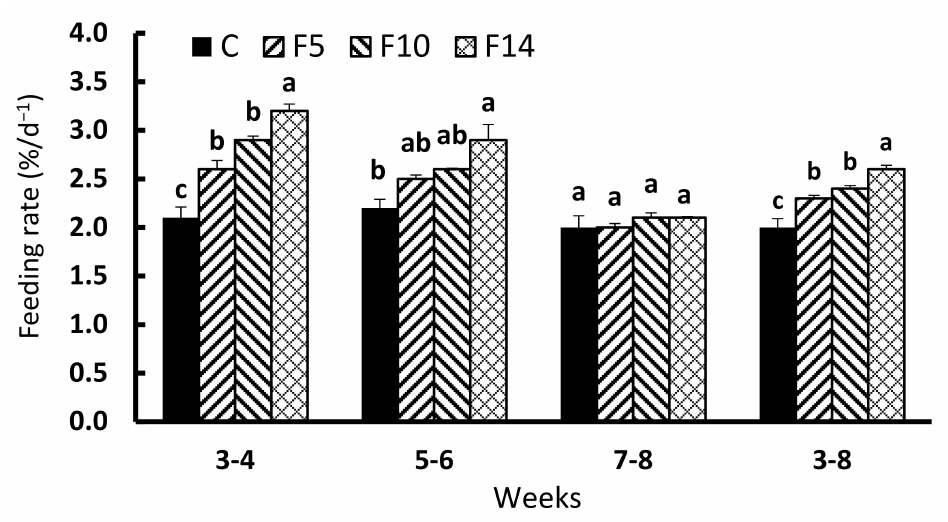
Figure 3. Changes in feeding rate of juvenile leopard mandarin fish ( Siniperca scherzeri ) subjected to four feeding regimens across an 8-week trial: Control (C), fish fed continuously; F5, fish fasted for 5 days (days 10–14); F10, fish fasted for 10 days (days 5–14); and, F14, fish fasted for 14 days (days 1–14), prior to all fasted fish being fed to satiation. Values (mean ± standard error, n = 3) in the same column with dissimilar letters are significantly different ( p < 0.05).